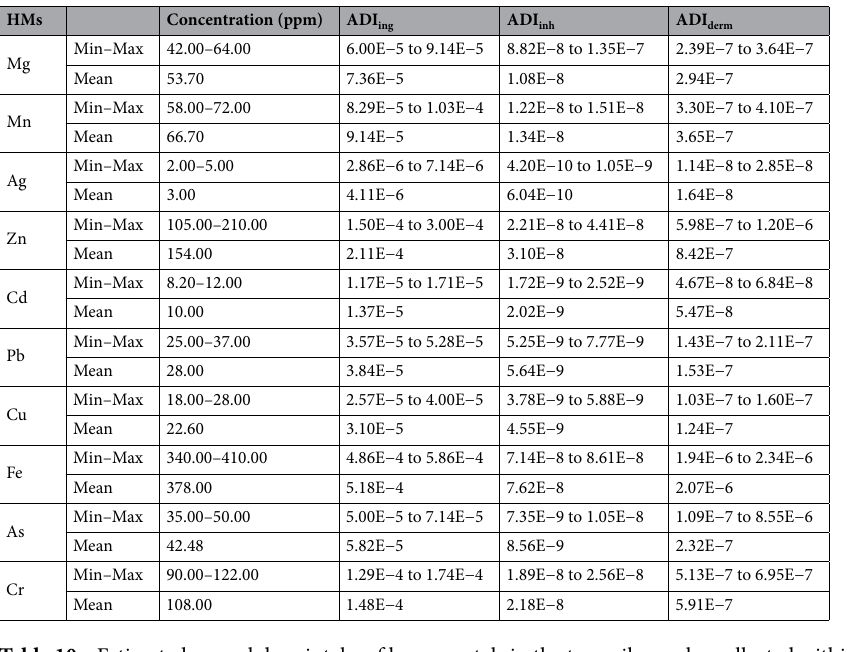
Table 10. Estimated annual dose intake of heavy metals in the top soil samples collected within the study site 31,35 .